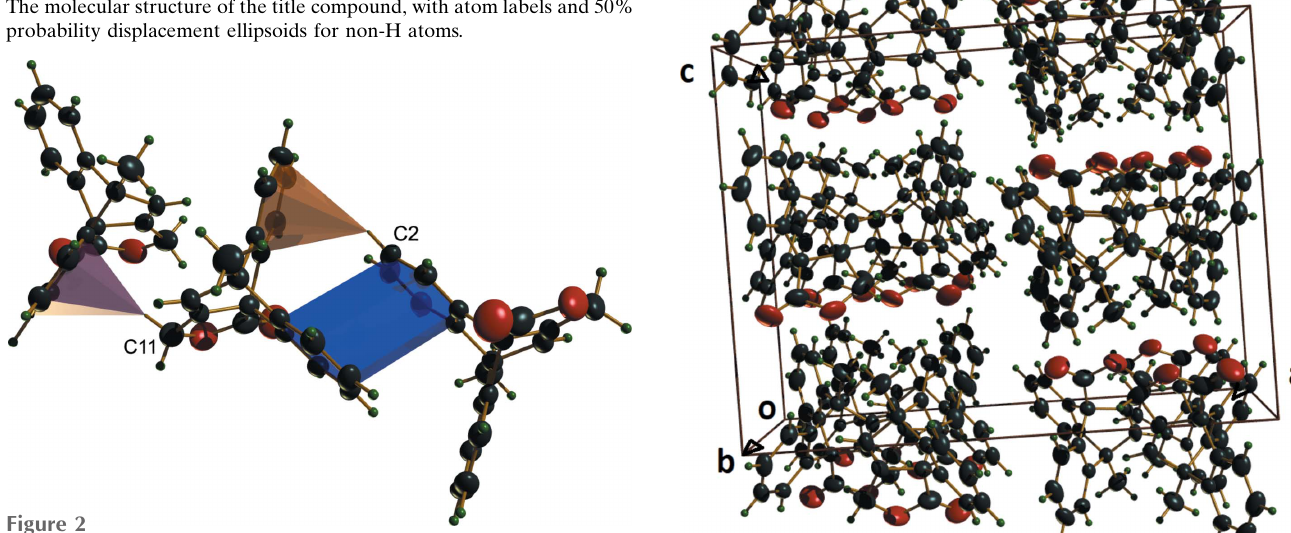
Figure 3 The packing viewed along the b axis.